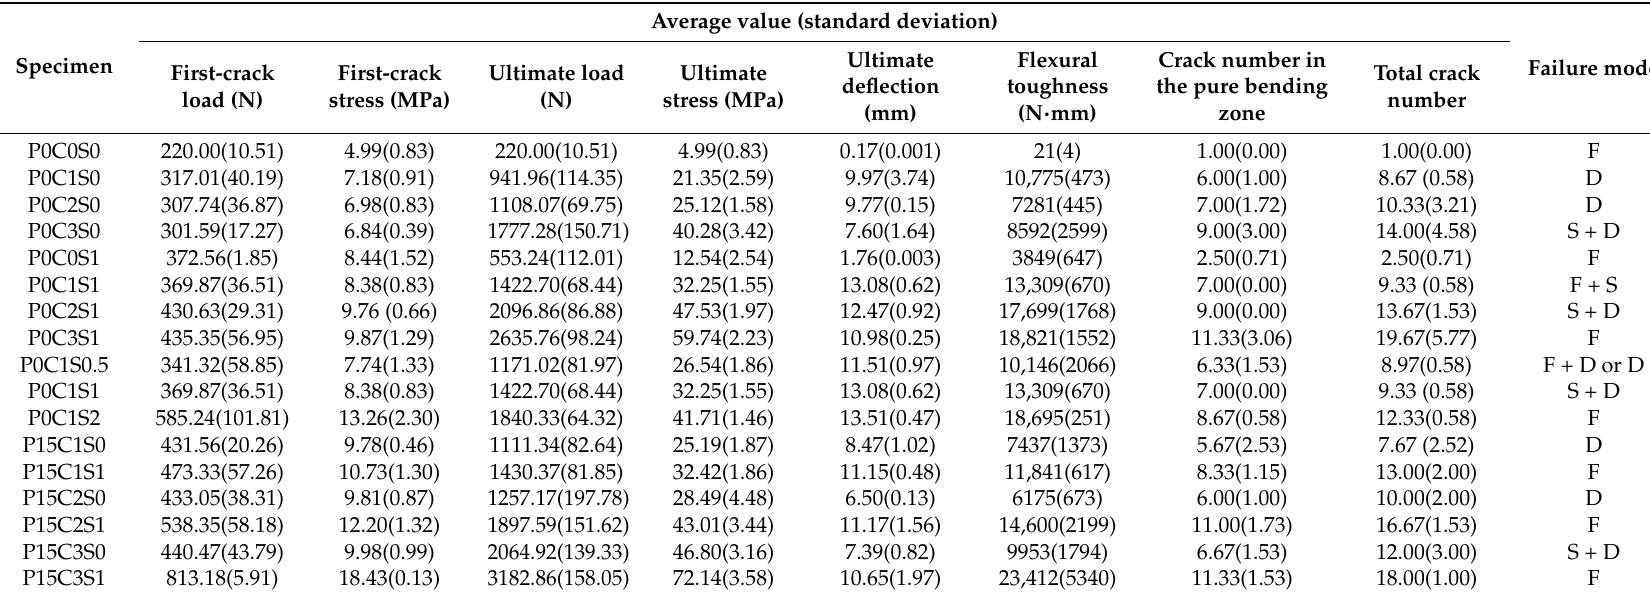
Table 6. Flexural behaviour of the textile-reinforced concrete (TRC) specimens with different number of textile layers, volume contents of steel fibres, and prestress.